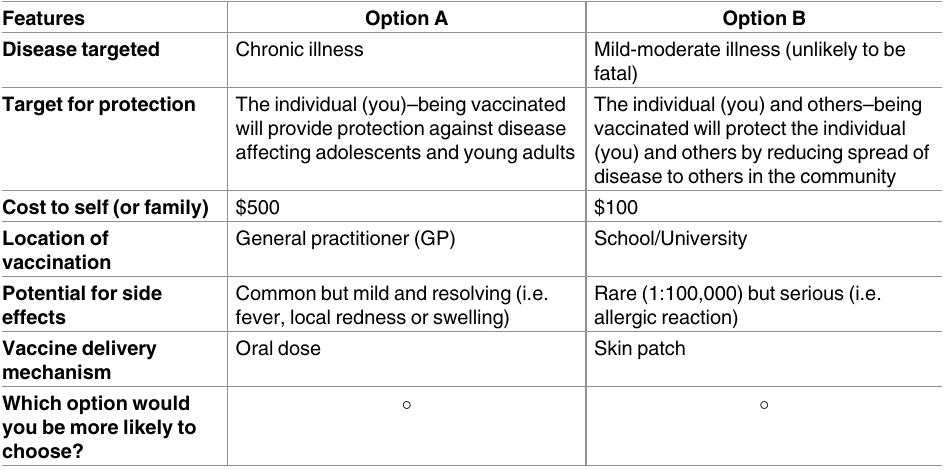
Table 1. Example of a DCE question. Please considerthat you are making a choice about receivinga vac- cine/s for yourself. Of the optionsin the table below(A or B), please select which option you would choose. Considering the possiblescenariosoutlinedbelow, which option wouldyou